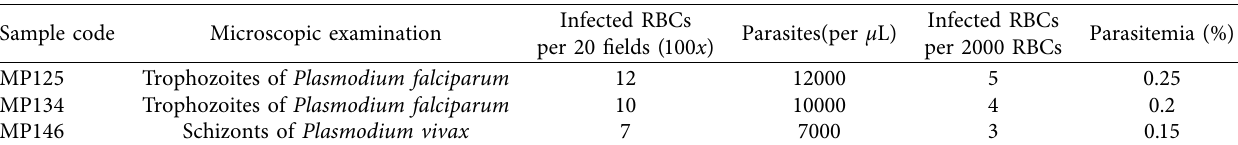
Table 1: Quantification of parasitemia using the RBC count method among Plasmodium species identified in the blood film using light microscopy.